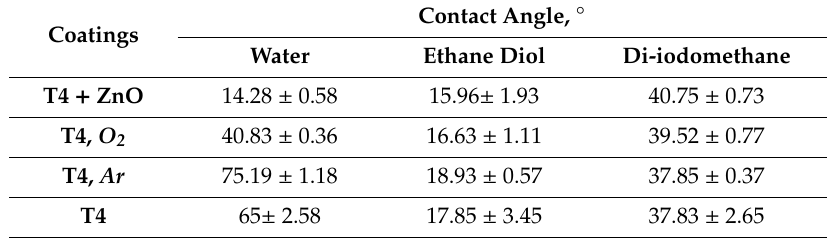
Figure 4. Static water contact angle and surface energy of modified T4 coatings. The inset image shows the contact angle less than 90 ◦ . Control consists of glass coverslip. Table 1. Contact angle of water, ethanediaol, and di-iodomethane on modified T4